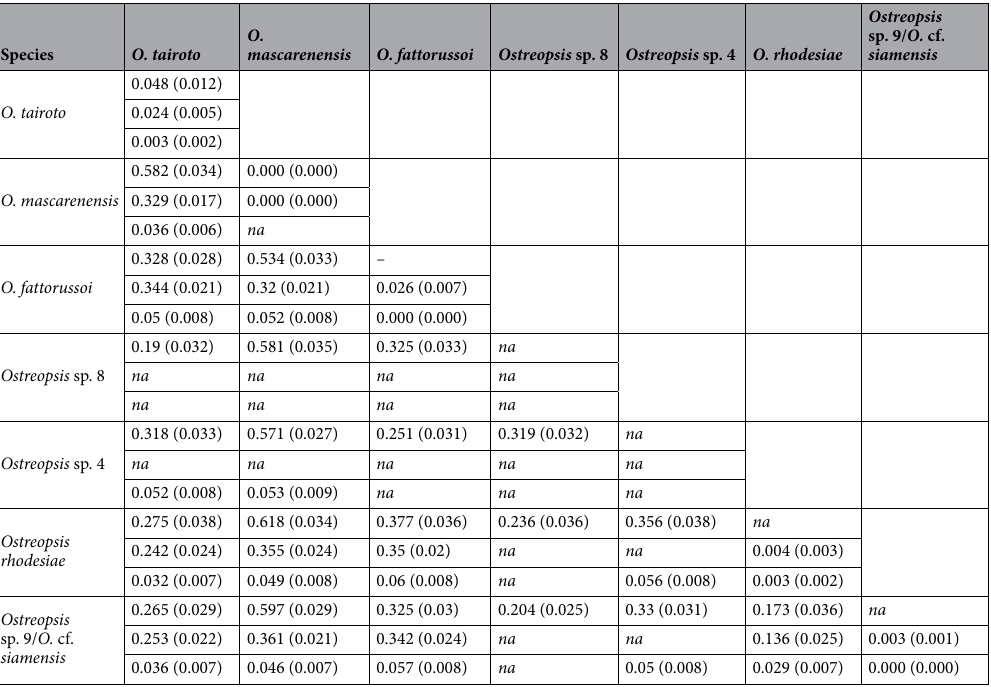
Table 4. Distance values (pairwise uncorrected p distances) based on the ITS/5.8S, D1-D3, D8-D10 LSU rDNA sequences respectively within and between Ostreopsis species closely related to O. tairoto . Standard error estimate(s) are shown in brackets and were obtained by a bootstrap procedure (1000 replicates). na represents no